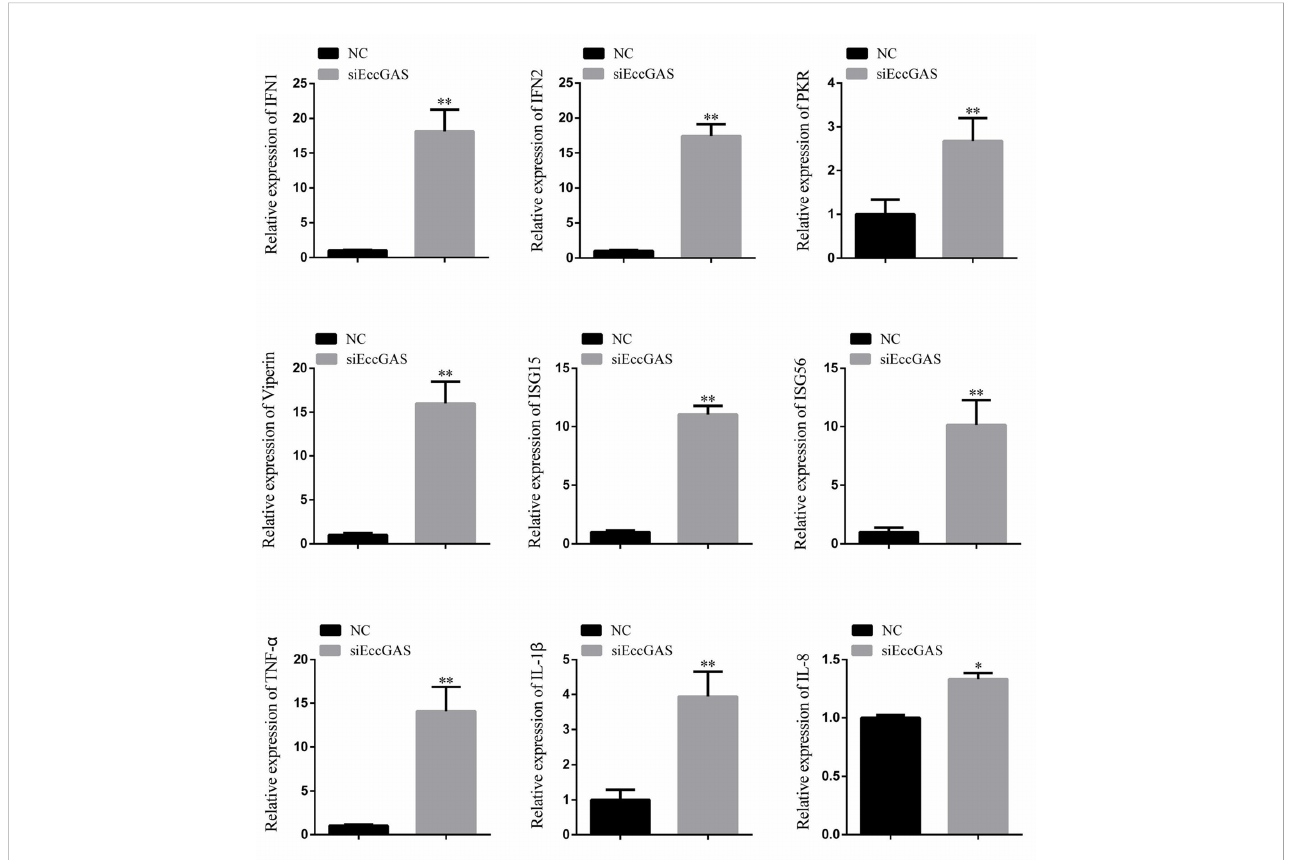
FIGURE 6 Silencing of EccGAS promoted the expression of host interferon-related genes and in fl ammation-related factors. Data are expressed as ratio to the control group. Error bars represent mean ± SD; * P < 0.05; ** P <